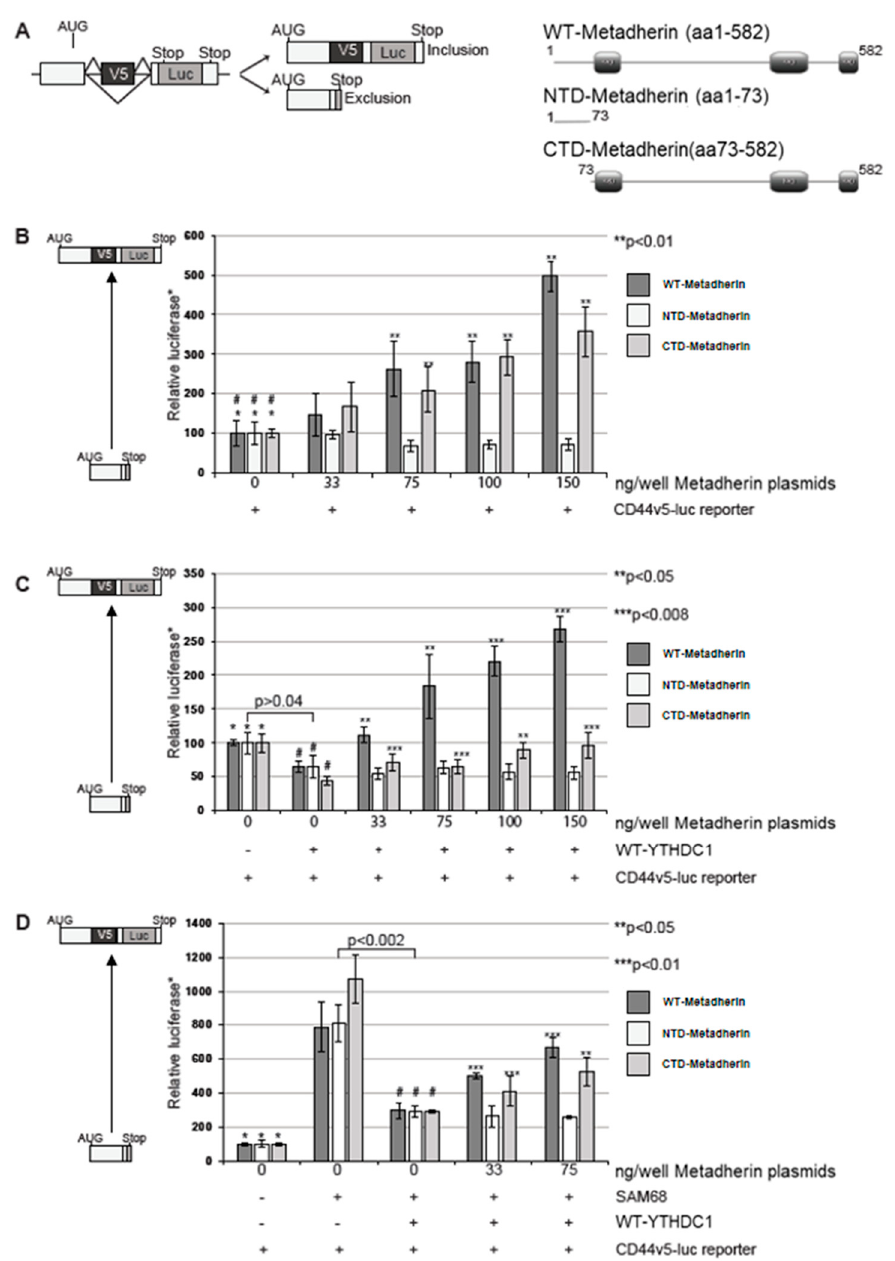
Figure 4. Metadherin promotes exon inclusion during splicing. ( A ) Left: Schematic representation of CD44v5-luc construct with v5 exon inclusion (top) and exclusion (bottom) Right: Schematic representation of metadherin constructs with wild-type (WT)-metadherin (top), N-terminal domain-metadherin (NTD-metadherim) (middle) and C-terminal domain metadherin (CTD-metadherin) (bottom) ( B ). COS7 cells were transfected with CD44v5-luc and increasing concentrations of the metadherin constructs: WT-metadherin (dark grey bars), NTD-metadherin (empty bars), CTD-metadherin (light grey bars). BOS β -galactosidase plasmid was also transfected to control for transfection efficiency. Luciferase activity normalised using a β -galactosidase activity and reported relative to the reporter alone (*). ( C ) COS7 cells were transfected with CD44v5-luc, BOS- β -galactosidase, YTHDC1 and increasing concentrations of the metadherin constructs and assayed as in (B). ( D ) COS7 cells were transfected with CD44v5-luc, BOS- β -galactosidase, YTHDC1, Sam68 and increasing concentrations of the metadherin constructs, grown and assayed as in (B). Schematics left of plots show exon exclusion represented by low relative luciferase and exon inclusion with high relative luciferase. Grey triangle represents increase in exon inclusion. P-values were calculated using a Student’s two-tailed t -test. ** / *** indicate significant differences compared to bars marked